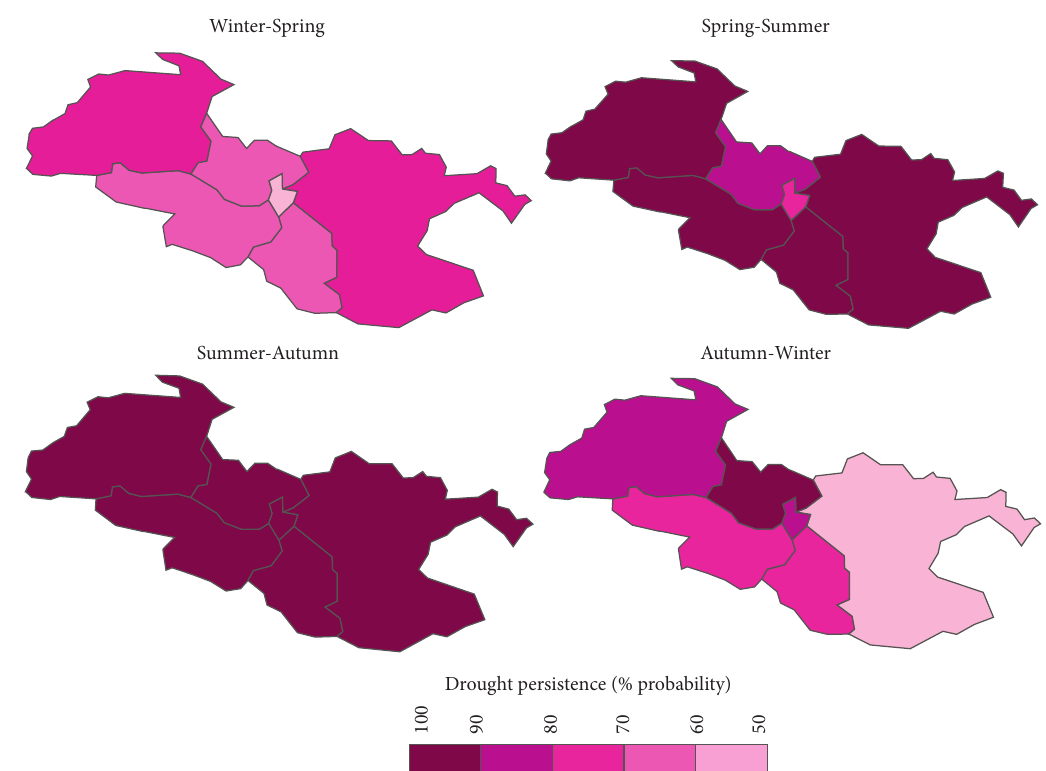
Figure 8: Drought persistence percent probability for all seasons in the selected